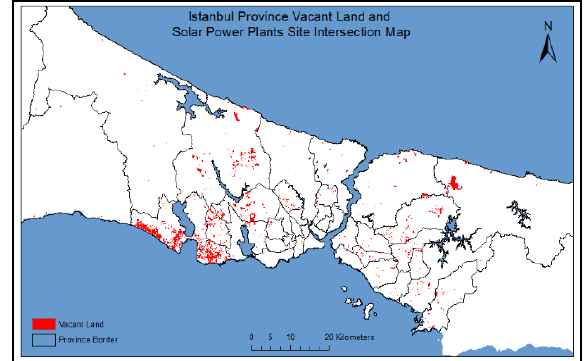
Figure 11. Istanbul Province Vacant Land and Solar Power Plants Site Intersection